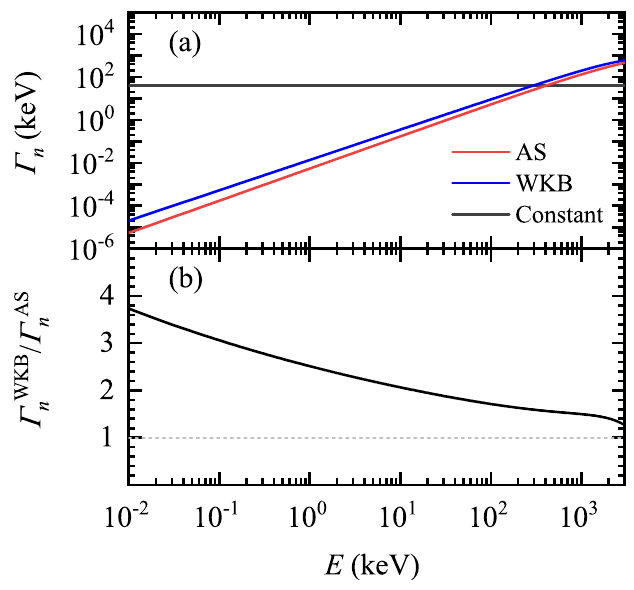
Figure 1. (a) A constant decay width (black line), and two decay widths Γ n ( E ) as a function of energy E , based on the penetration factors from the asymptotic solution (red line) and the WKB approximation (blue line), for 16 O( n ,γ ) 17 O, respectively. (b) ratio of Γ WKB